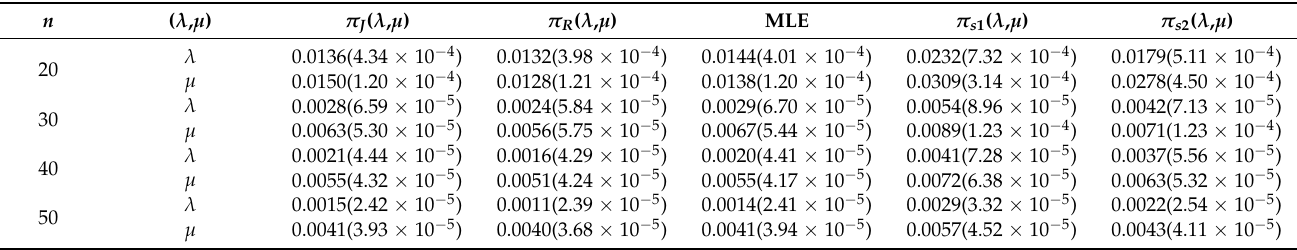
Table 3. ABs and MSEs (within bracket) of parameters based on MLE, subjective Bayesian and objective Bayeisan estimations in case